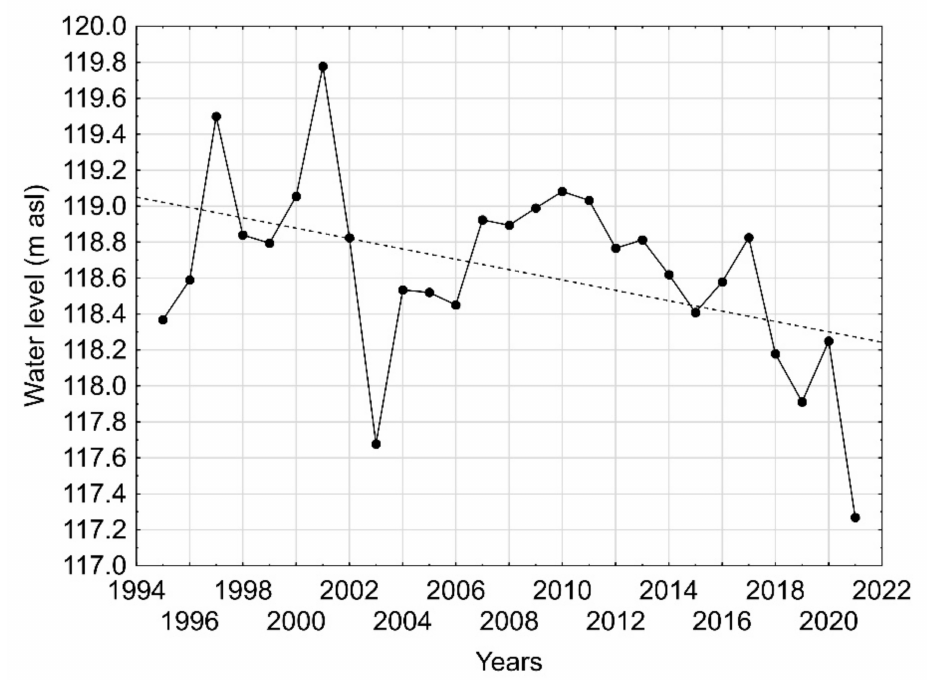
Figure 5. Changes in mean annual water levels in the Jeziorsko reservoir in the period 1995–2021. Mean monthly water flows through the turbines of the hydropower plant on the Jeziorsko dam reservoir varied from 16 m 3 s − 1 to 71.2 m 3 s − 1 . The greatest water supply to the power plant occurred in April, averaging 45.2 m 3 s − 1 , and the lowest in June, averaging 34.4 m 3 s − 1 (Figure 6). The range of changes in water flows through the power plant